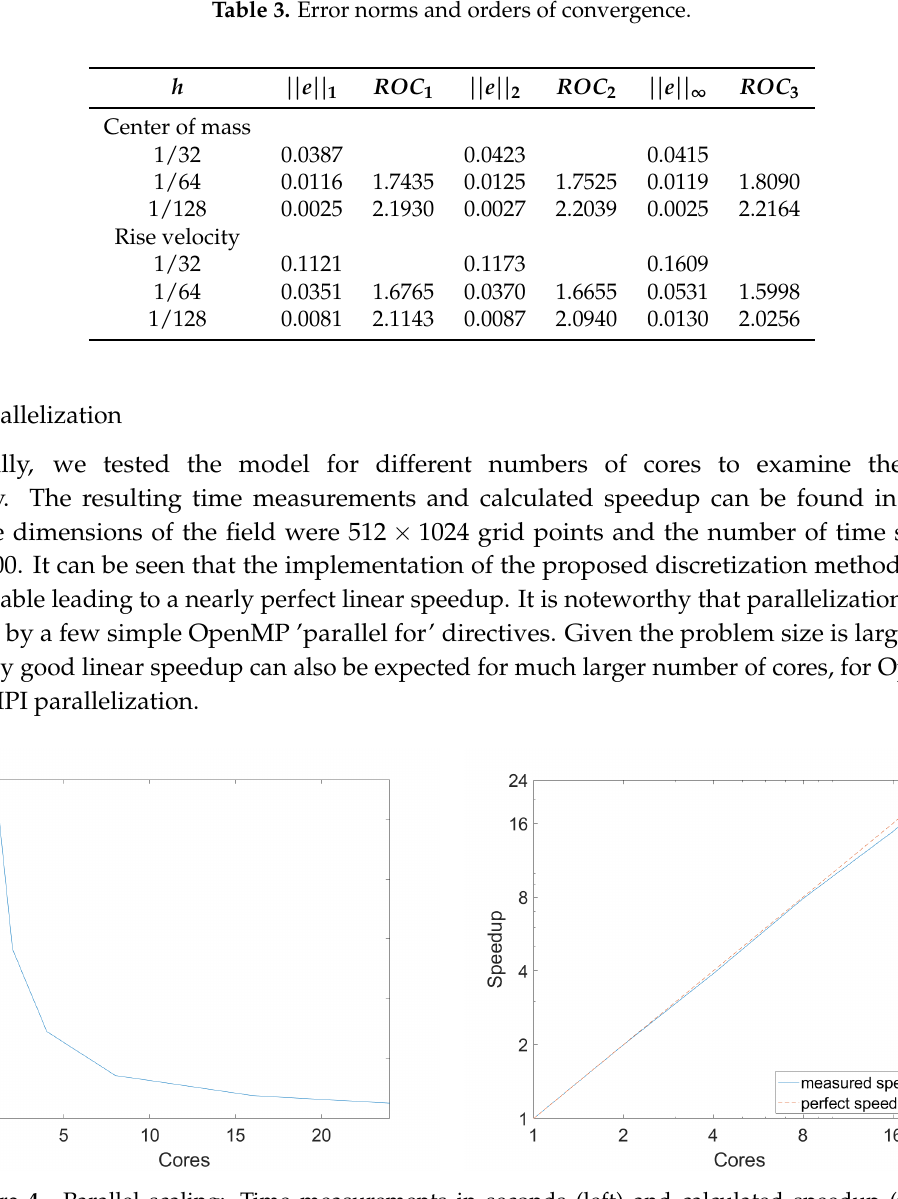
Table 3. Error norms and orders of convergence.